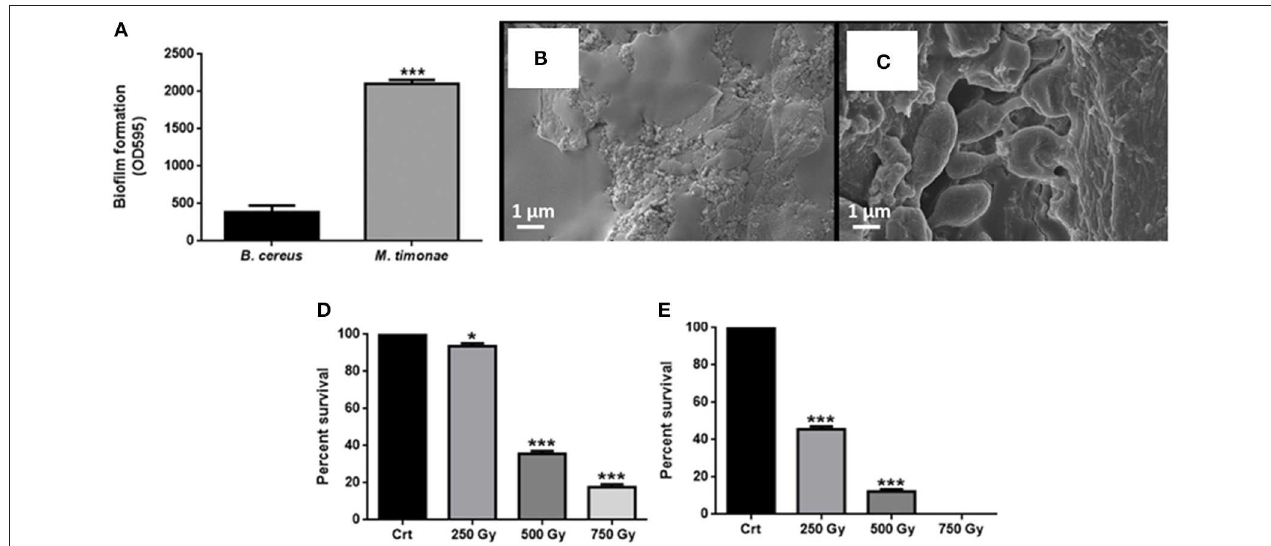
FIGURE 2 | Evaluation of biofilm formation and cell viability after irradiation. (A) Biofilm formation capacity of B. cereus and M. timonae after 24h of incubation at 30 ◦ C. For statistical analysis one-way ANOVA method coupled with the Bonferroni post-test was used (*** p < 0.001). (B) FE-SEM micrograph of M. timonae biofilm after 24h at 30 ◦ C, biofilm matrix, (C) particular of M. timonae cells. (D,E) Indicate respectively B. cereus and M. timonae cells recovered after irradiation. Crt represent the recovery from unexposed samples, set to 100%. To evaluate statistical significance a one-way ANOVA analysis with the Bonferroni post-test was used (* p < 0.5. and *** p < 0.001 with respect to